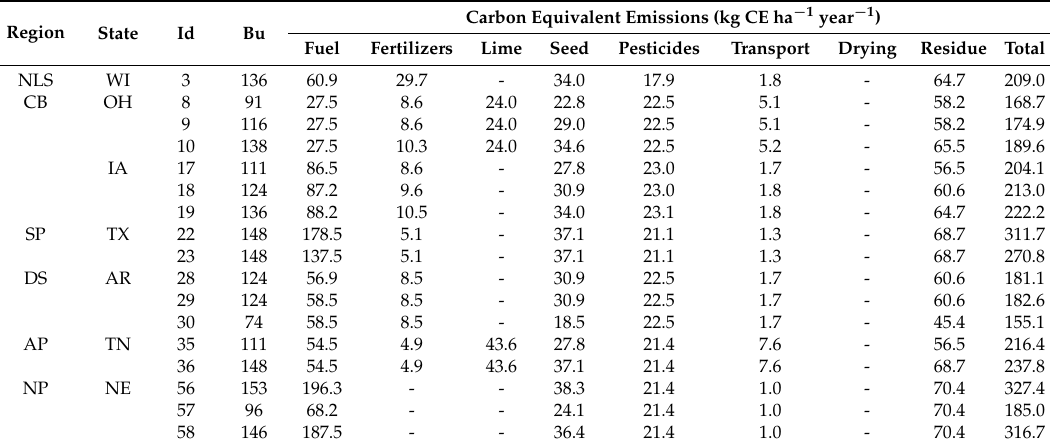
Table A7. Carbon equivalent emissions for soybean systems in the United States. Region